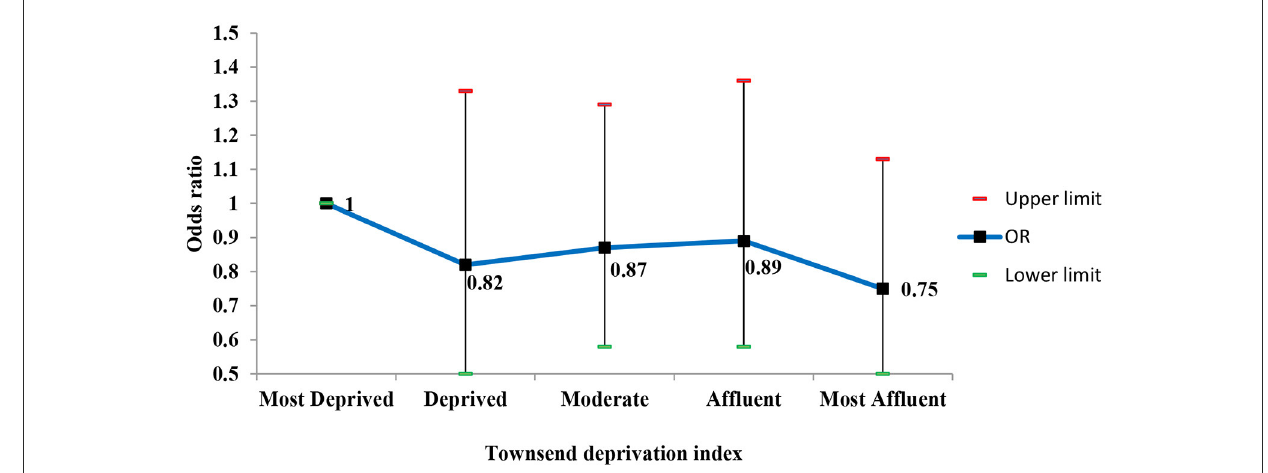
FIGURE3 Adjusted odds ratios (95% CI) of hearing loss according to the Townsend deprivation